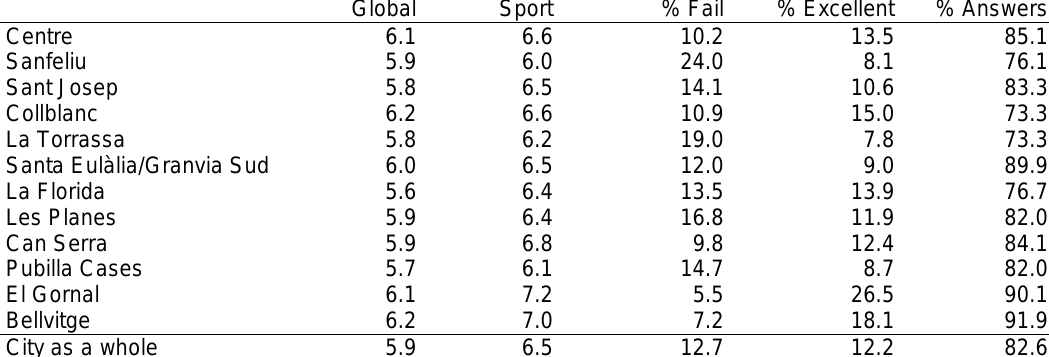
Table 1. Average assessment of municipal management by neighbourhood